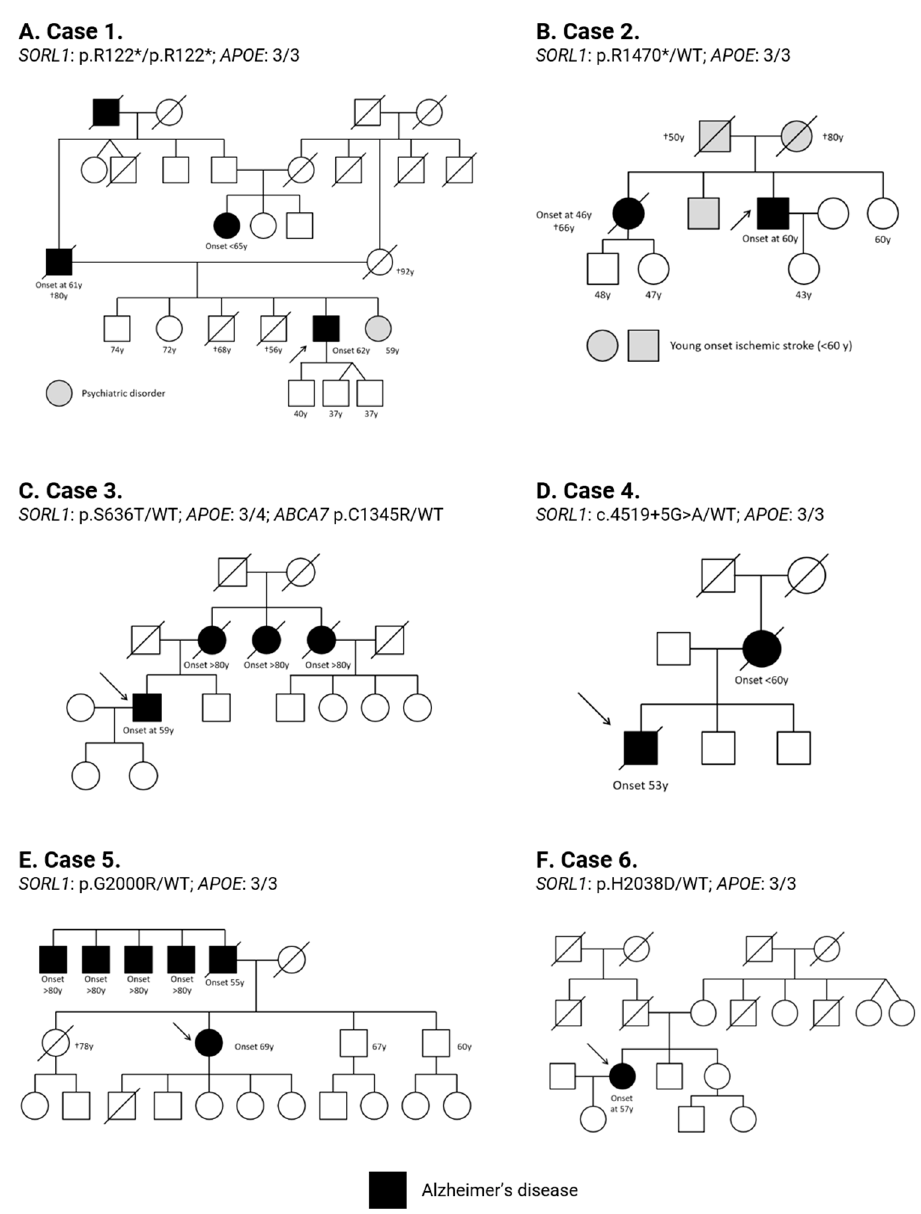
Figure 2. Familial pedigree of cases with SORL1 variants reported in this study. ( A ) case 1; ( B ) case 2; ( C ) case 3; ( D ) case 4; ( E ) case 5; and ( F ) case 6. Arrows show probands; black-filled symbols represent AD affected individuals. Gray-filled symbols represent relatives affected with other neurological issues. Genotypes for SORL1 and APOE genes are shown. WT: wild-type allele.